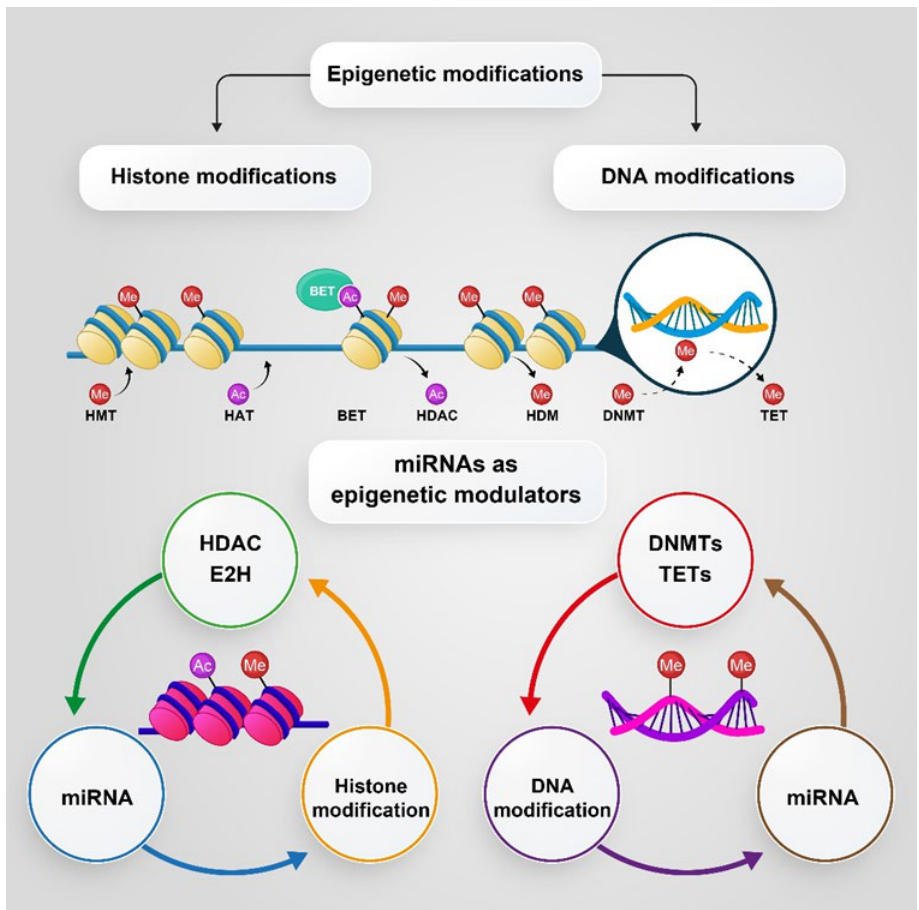
Figure 3. Epigenetic marks including DNA methylation, histone modification, and the relationship between miRNAs and epigenetics.